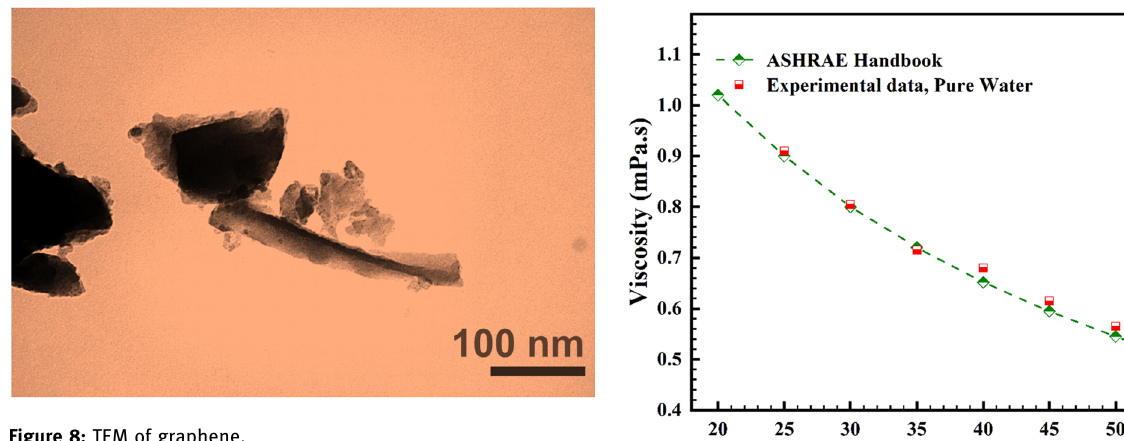
Figure 8: TEM of graphene.